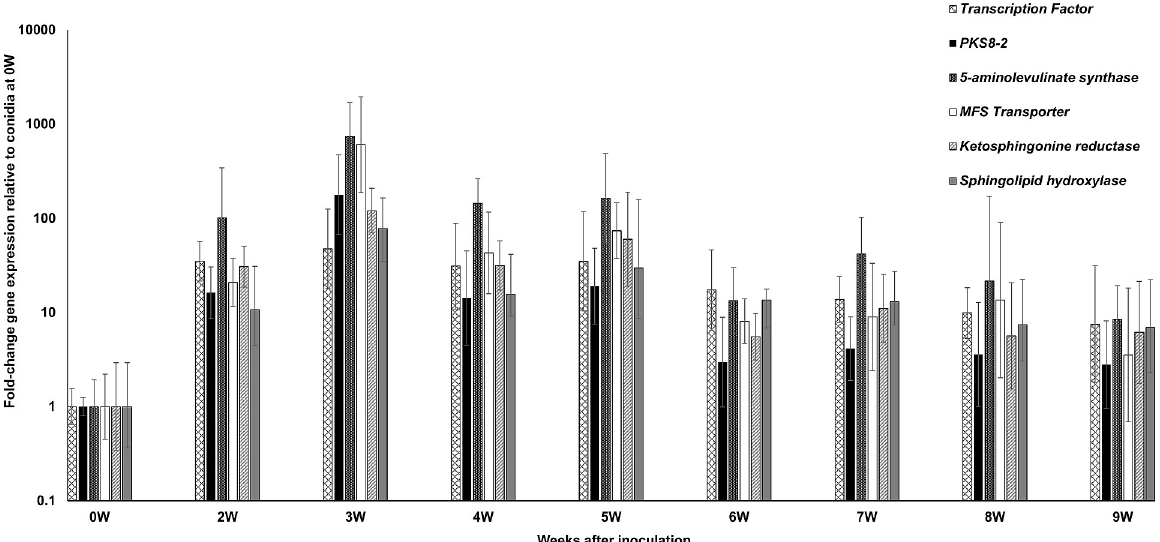
Fig 3. Time course of fold-change gene expression of PKS8-2 cluster genes in wild type P . fijiensis isolate 10CR1-24 in infected banana relative to expression in conidia. PKS8-2 cluster genes assessed include the transcription factor, PKS8-2 , the 5-aminolevulinate synthase, the MFS transporter, the ketosphinganine reductase, and the sphingolipid hydroxylase genes. To determine gene expression, tissue was harvested from infected banana plants at weekly intervals starting at 2 weeks through 9 weeks post-inoculation. Fold-change gene expression is shown relative to the expression at 0 weeks (in conidia) which is set to 1, with error bars indicating standard error from three biological replicates. W = week.